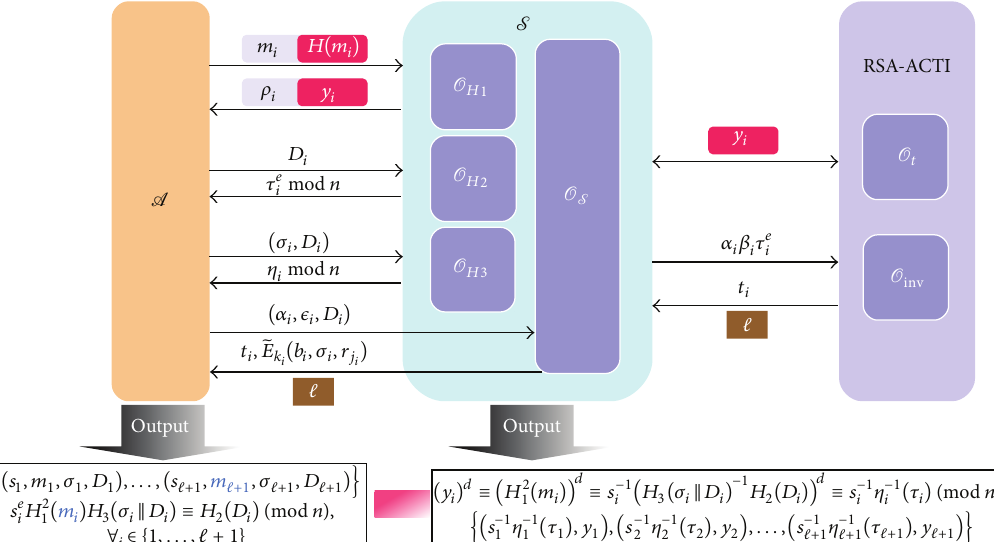
Figure 6: The proof model of FG-1.